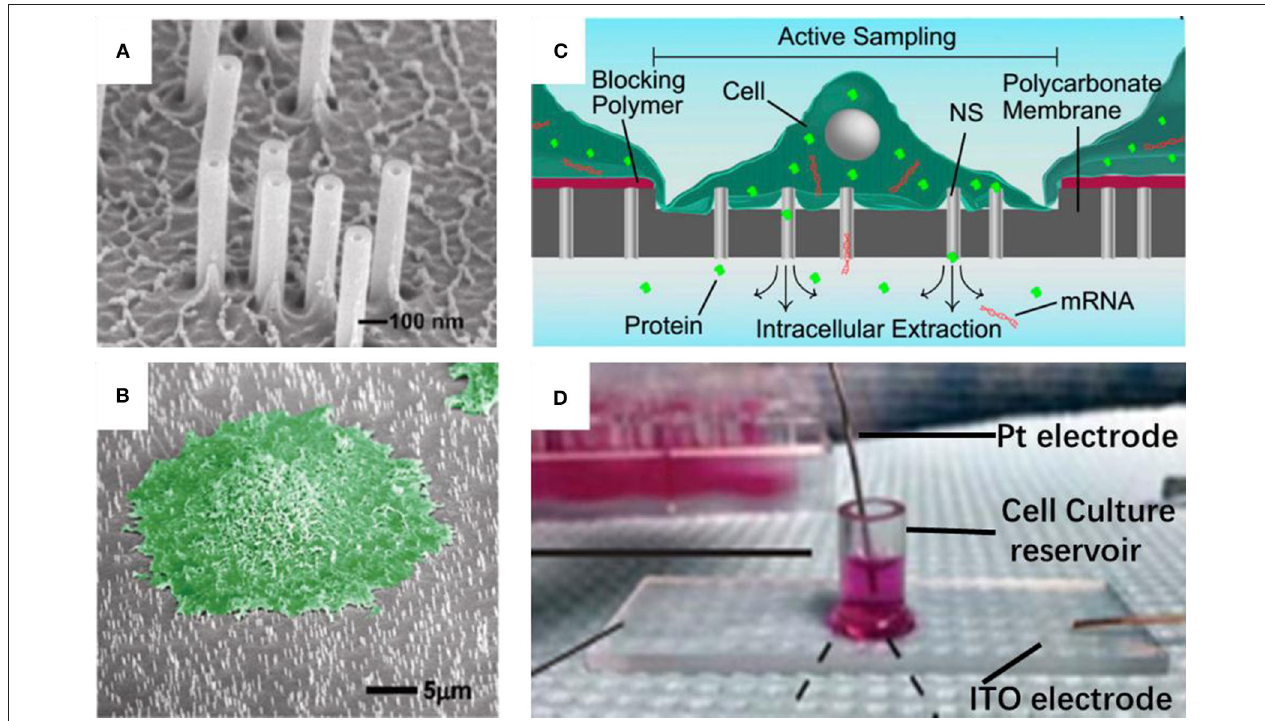
FIGURE 1 | Scanning electron micrograph for nanostraw membrane (A) and critical point dried cell cultured on nanostraw membrane ( B , false colored green); schematic (C) and device pictures (D) for nanostraw electroporation system.